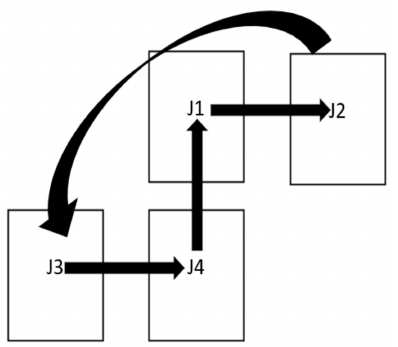
Figure 3. Schematic of the illustration of the work